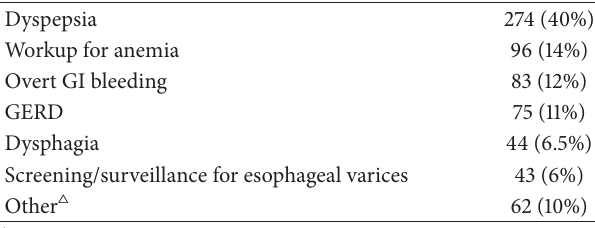
Table 2: Indication for esophagogastroduodenoscopy.